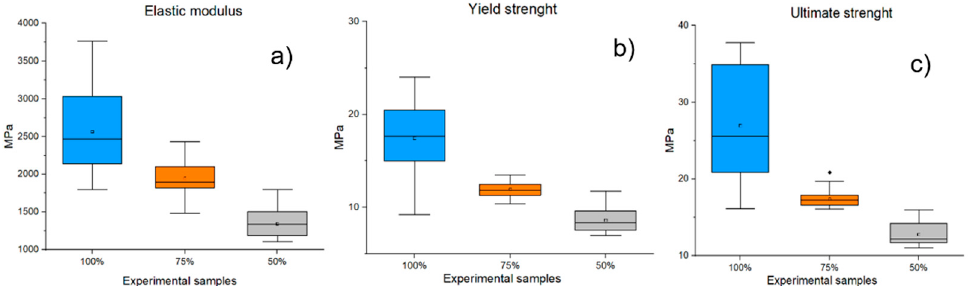
Figure 11. Results of mechanical tensile testing for PLA/PHB + HA/TCP material with infills of 100%, 75%, and 50% infills of experimental samples ( a ) Elastic modulus; ( b ) Yield point; ( c ) Ultimate strength). ( c ) Ultimate